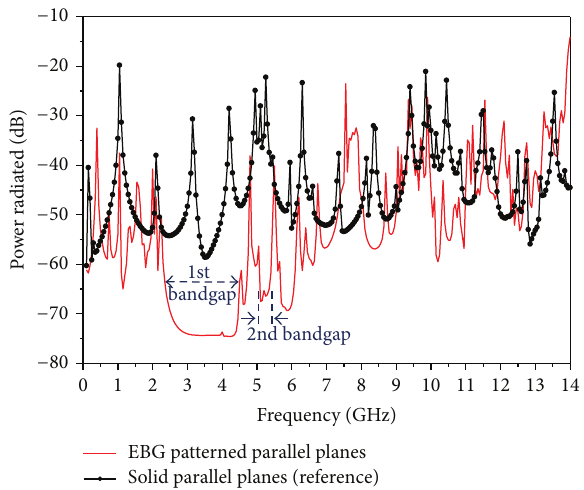
Figure 7: Real radiated power versus frequency from two setups defined in the caption of Figure